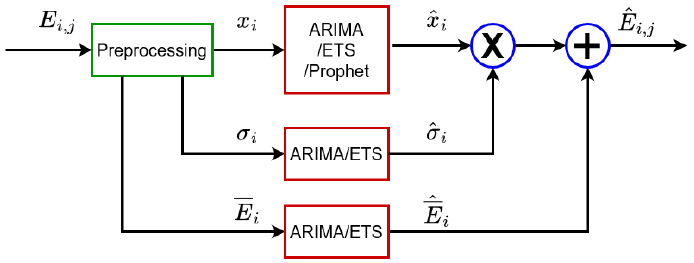
Figure 7. A block diagram of pattern-based MEL forecasting